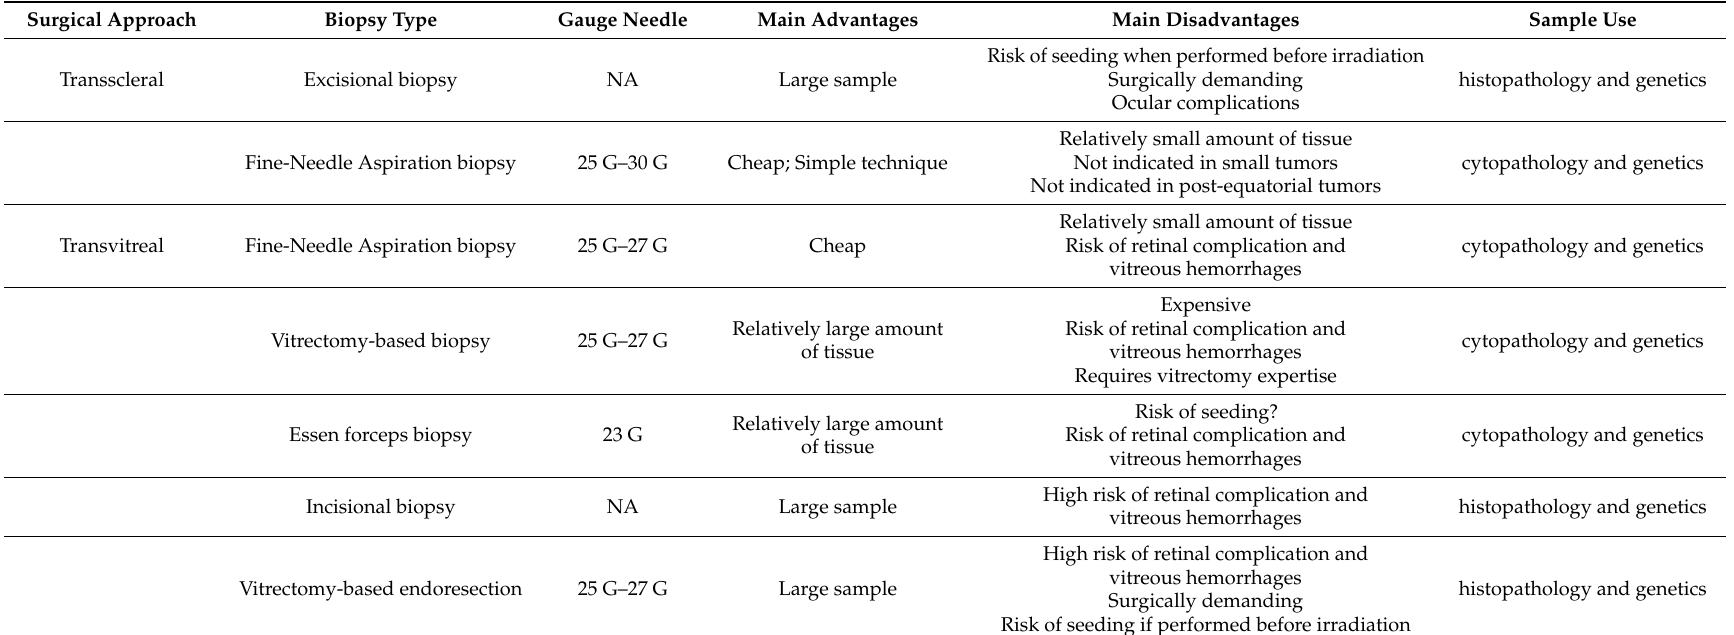
Table 1. Biopsy approach